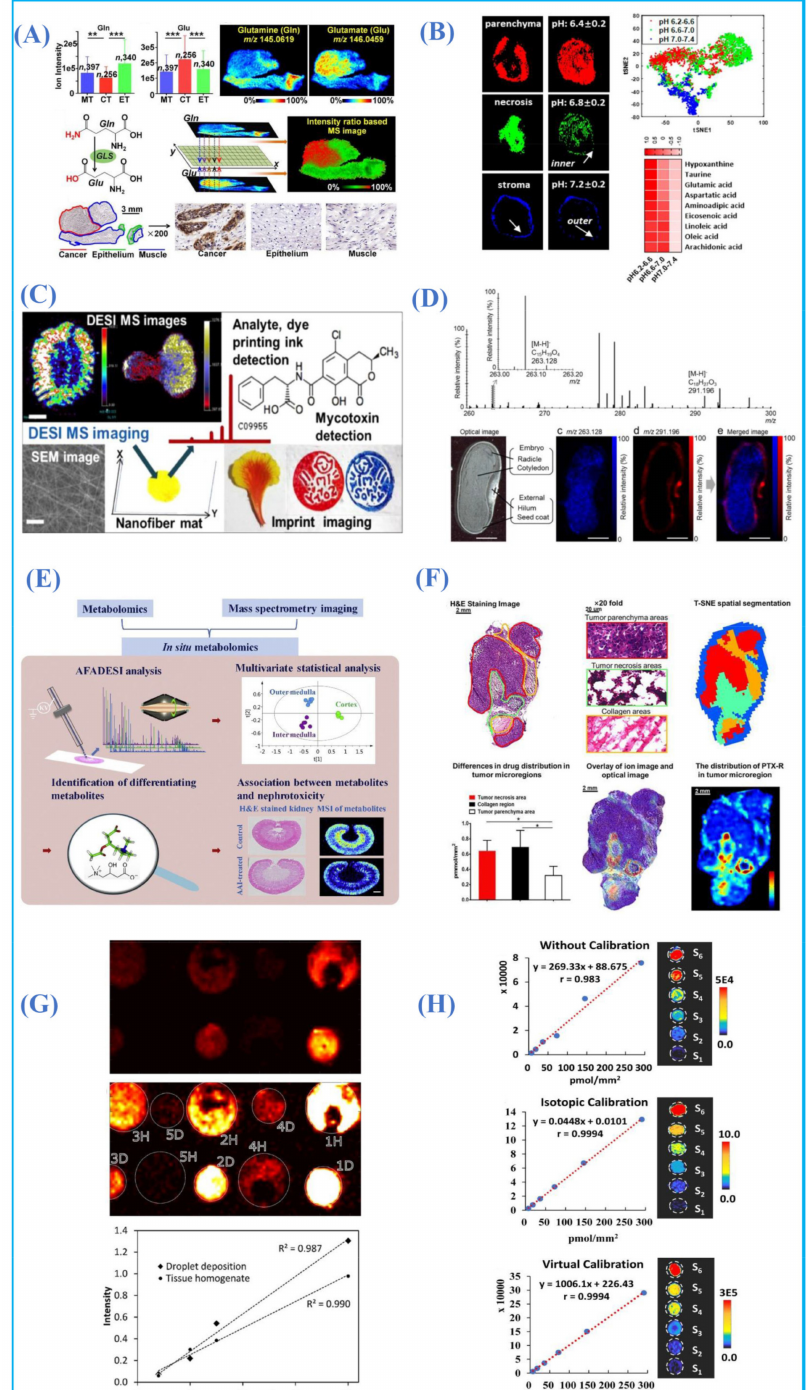
Figure 7. ( A ) In situ visualization of crucial metabolites and metabolic enzymes in the glutamine metabolism pathway. [117] Copyright (2019) National Academy of Sciences. ( B ) Images of the acidic TME and contributive acidic species. Reprinted with permission from the authors of [120].